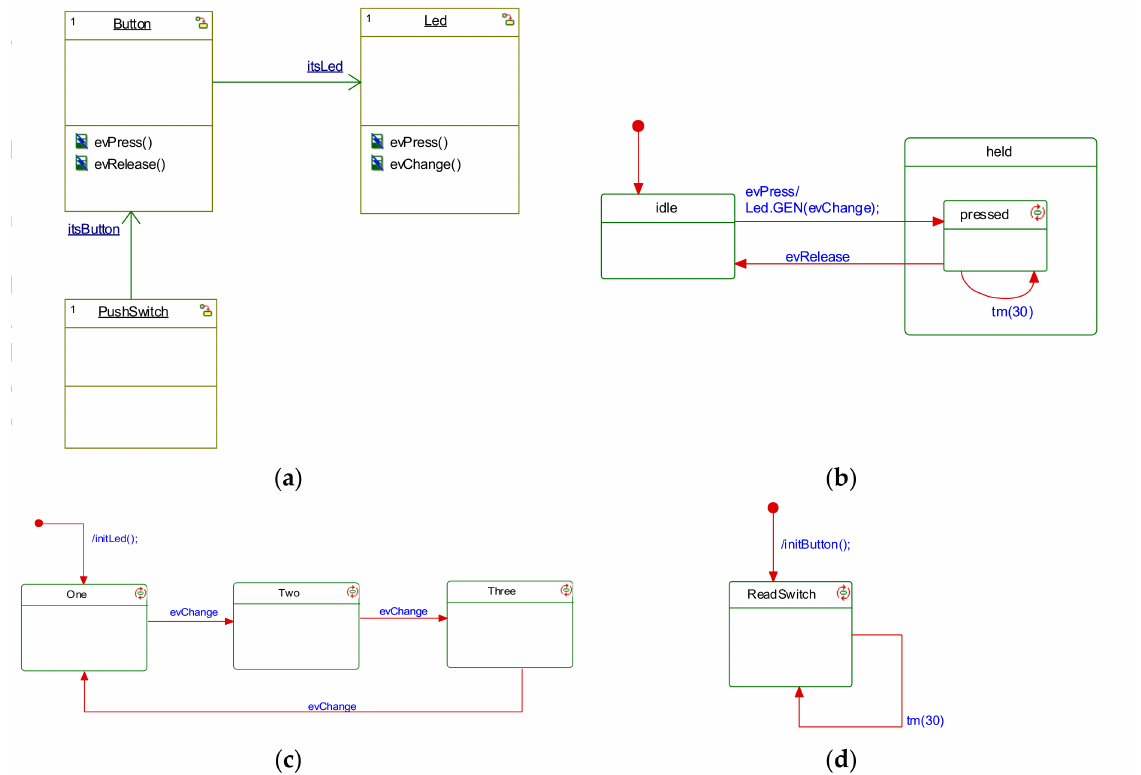
Figure 5. Object Model Diagram and state chart for the button switch project: ( a ) Object Model Diagram of the project; ( b ) State chart for the Button object; ( c ) State chart for the Led object. ( d ) State chart for the PushSwitch object.